Question: Looking at the figure, what chart type is it?
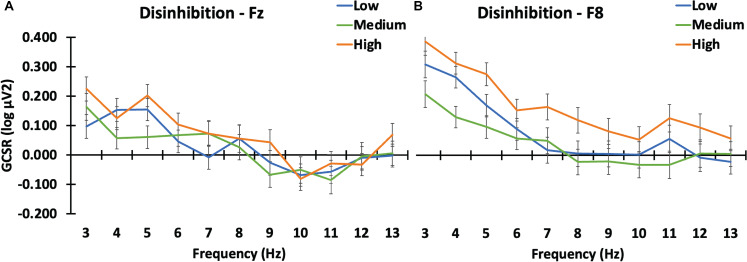
Answer: bar